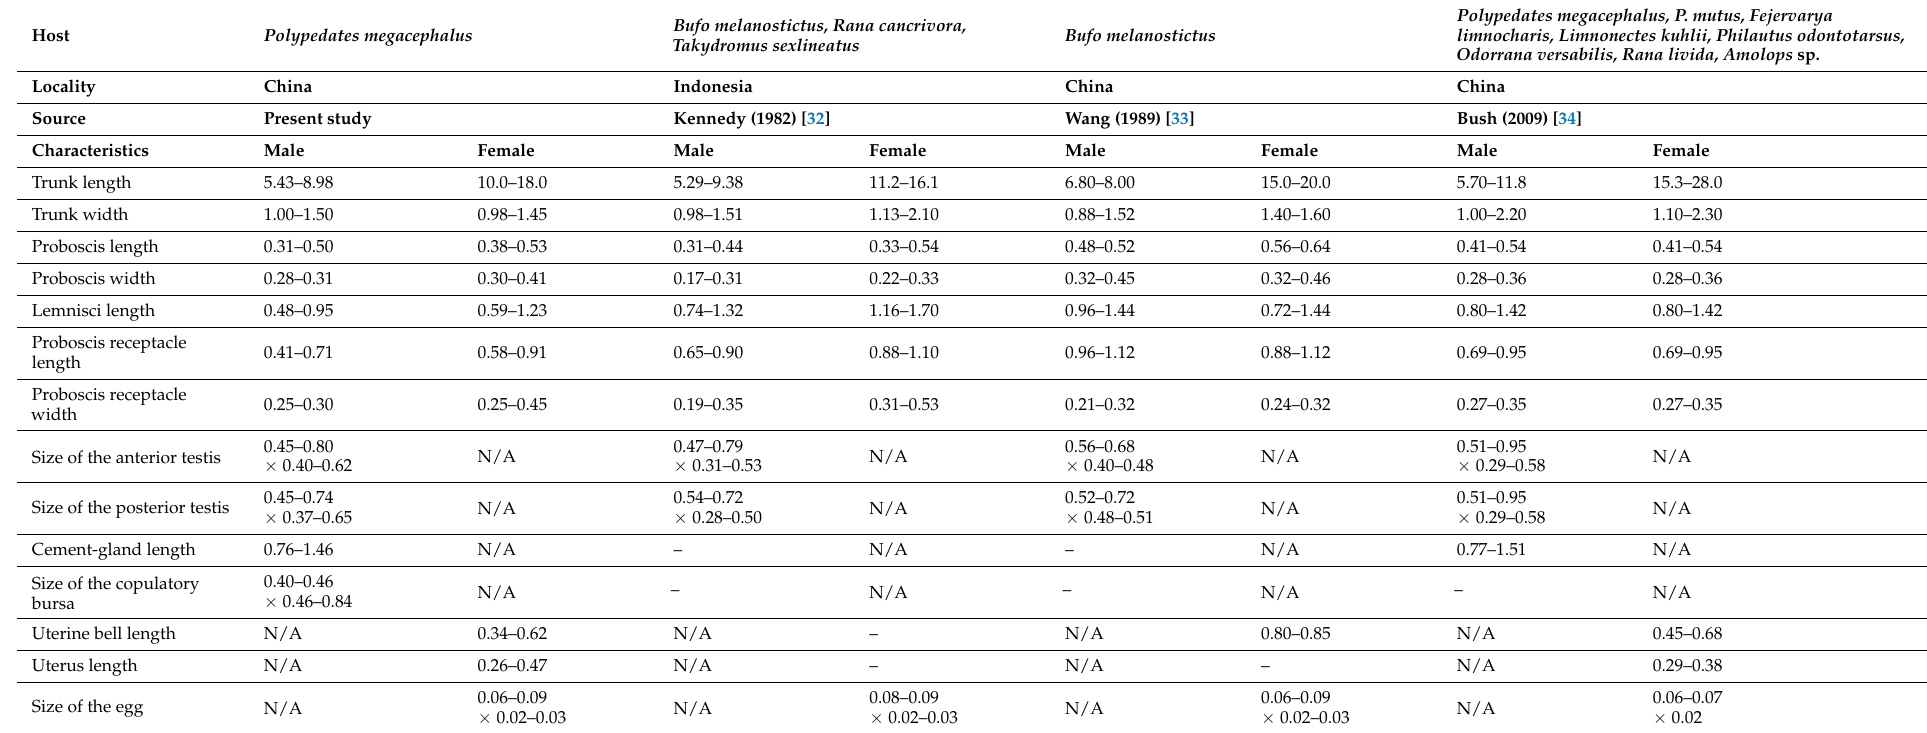
Table 3. Comparative morphometric data for Pseudoacanthocephalus bufonis (all measurements are in